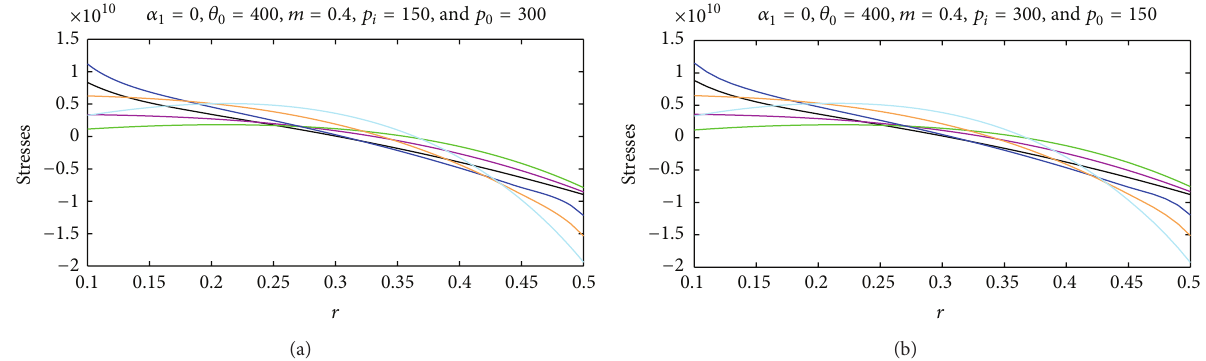
Figure 3: Elastic-plastic stresses in a rotating cylinder with constant thickness and constant density with thermal effects ( 𝜃 0 = 400 ) with parameters 𝑒 1 = 0, 1, 2 and strain hardening measure 𝑚 = 0.4 under internal and external pressure.